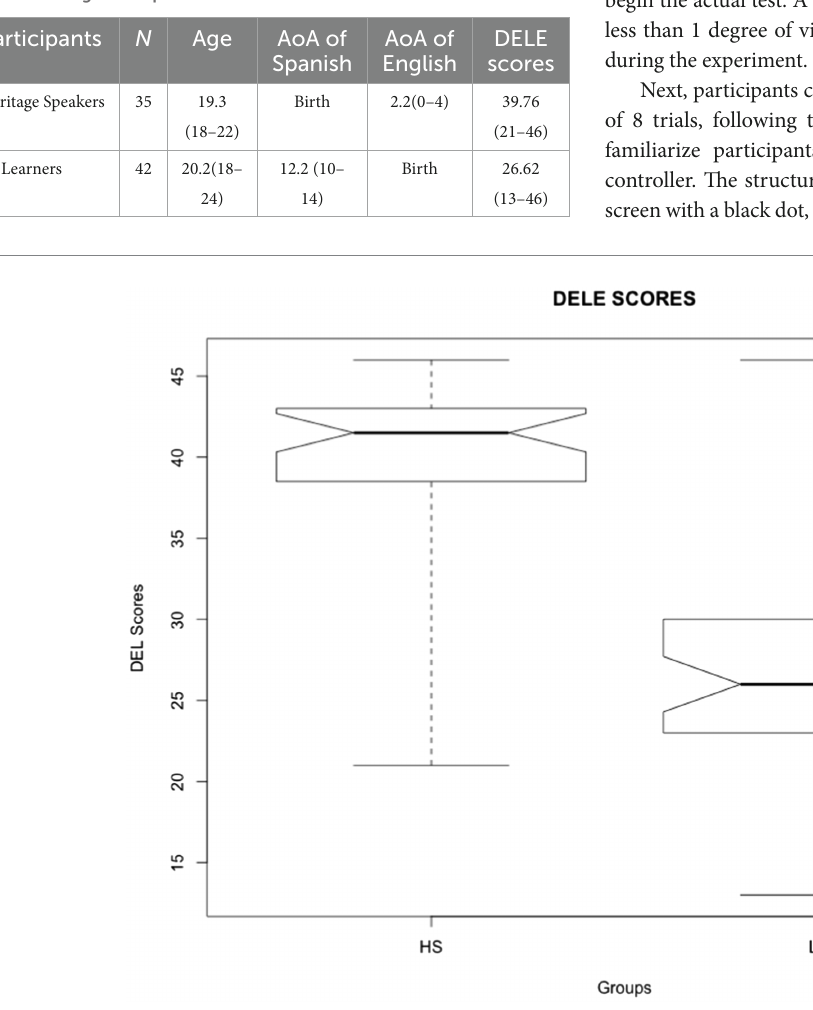
TABLE 2 Background questionnaire information.